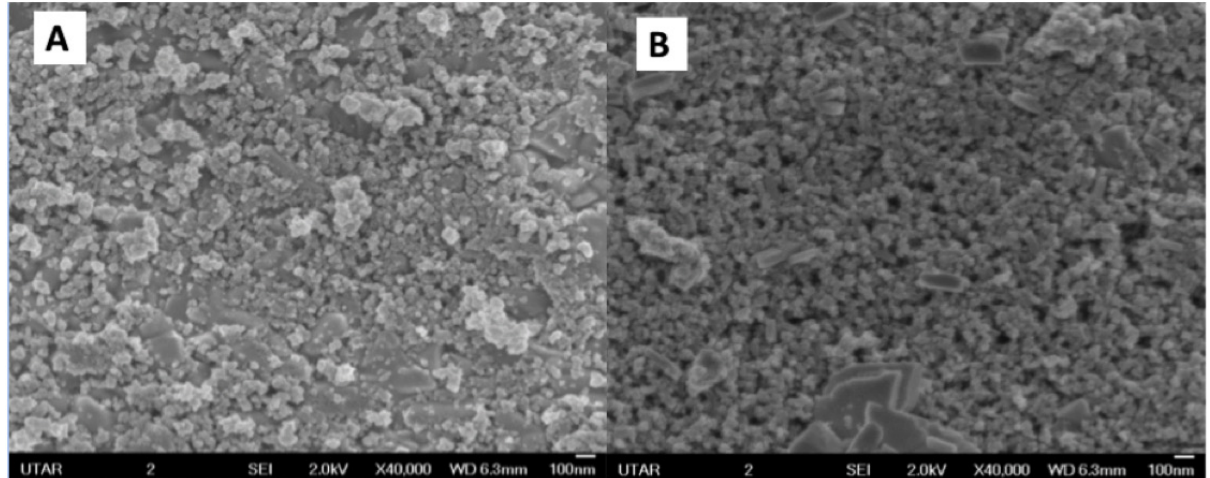
layer; (b) TiO /SnS 2 2